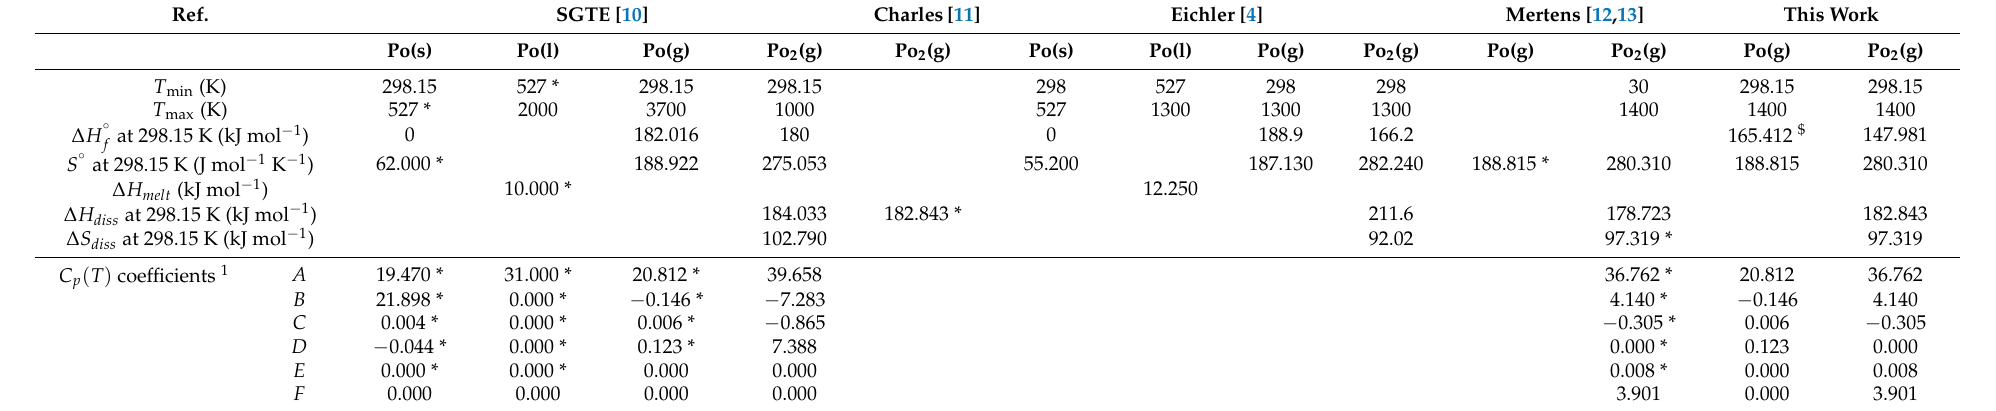
Table 2. Thermochemical data for the calculation of the vapor pressure of polonium. Values marked with (*) are selected in the present work as input. In the last two columns, the values selected and optimized in this work are summarized. Values marked with ($) were optimized to fit the experimental vapor pressure data.